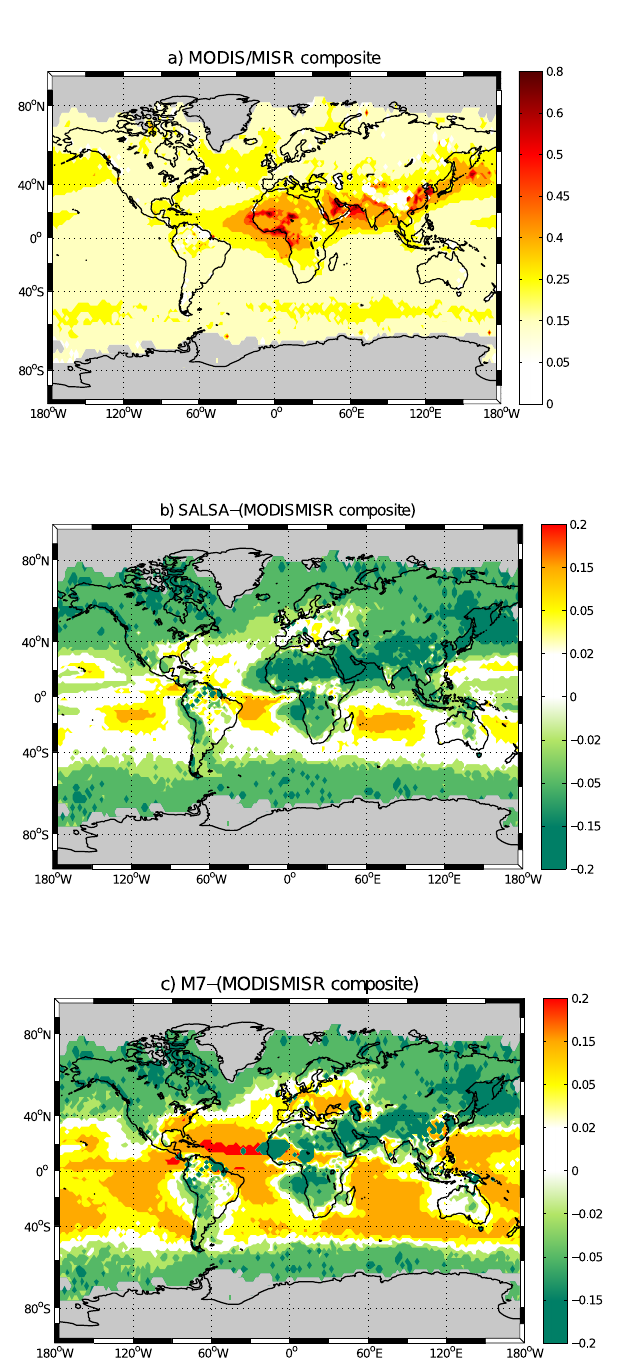
Fig. 9. Composite of retrieved annual mean of aerosol optical depth composite of MODIS and MISR (a) . The difference of AODs between MODIS/MISR composite and SALSA (b) and M7 (c) . Negative values indicate higher AOD with MODIS/MISR composite. Areas with no data are marked with gray.